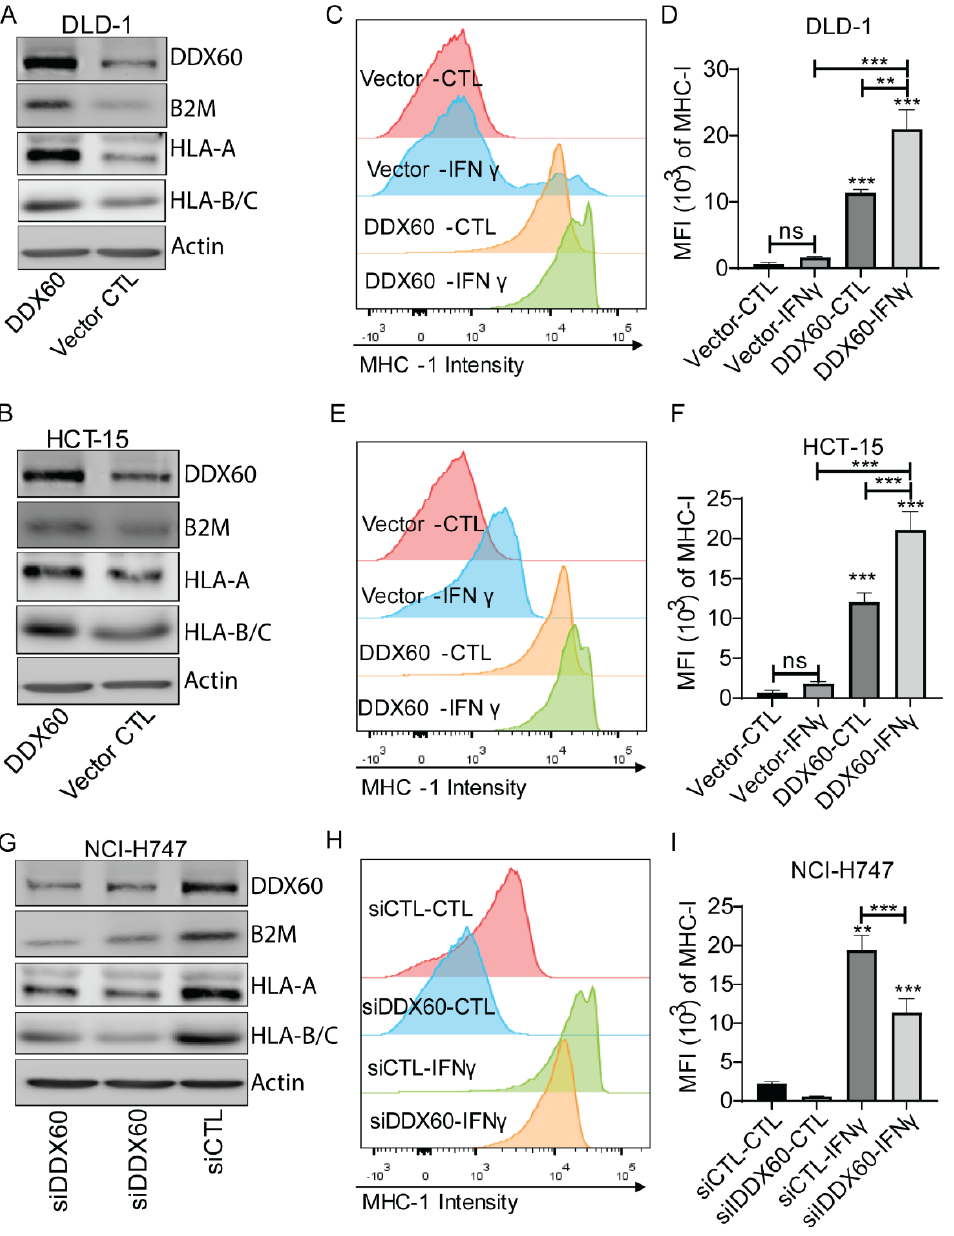
Figure 4. DDX60 regulates the expression of MHC-I molecules in CRC cells. ( A , B ). Western blotting images showed the expression of DDX60, B2M, and Actin in vector control or DDX60-overexpressed DLD-1 ( A ) and HCT-15 ( B ). ( C – F ) FACS analysis of MHC-I expression in vector control or DDX60-overexpressed DLD-1 ( A ) and HCT-15 ( B ) with/without IFN γ treatment. ( G ) Western blotting images showed the expression of DDX60, B2M, and Actin in NCI-H747 cells treated with siRNA of nontarget control (siCTL) or DDX60 for 48 h. ( H , I ) FACS analysis of MHC-I expression in control (siCTL) and DDX60-Knockdown NCI-H747 cells with/without IFN γ stimulation. p values were calculated by one-way analysis of variance (ANOVA) with Tukey’s multiple comparison. ns: p ≥ 0.05; **: p <0.01; ***: p <0.001